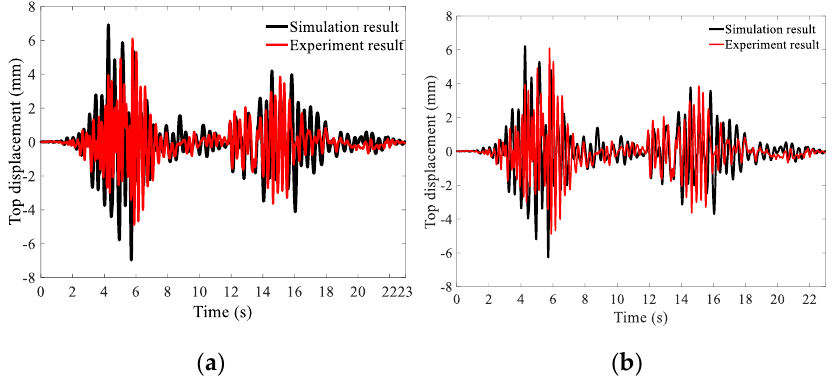
Figure 11. Comparison of top displacement curves . ( a ) Model considering axial – shear – bending interaction. ( b ) Model without considering axial – shear – bending interaction .